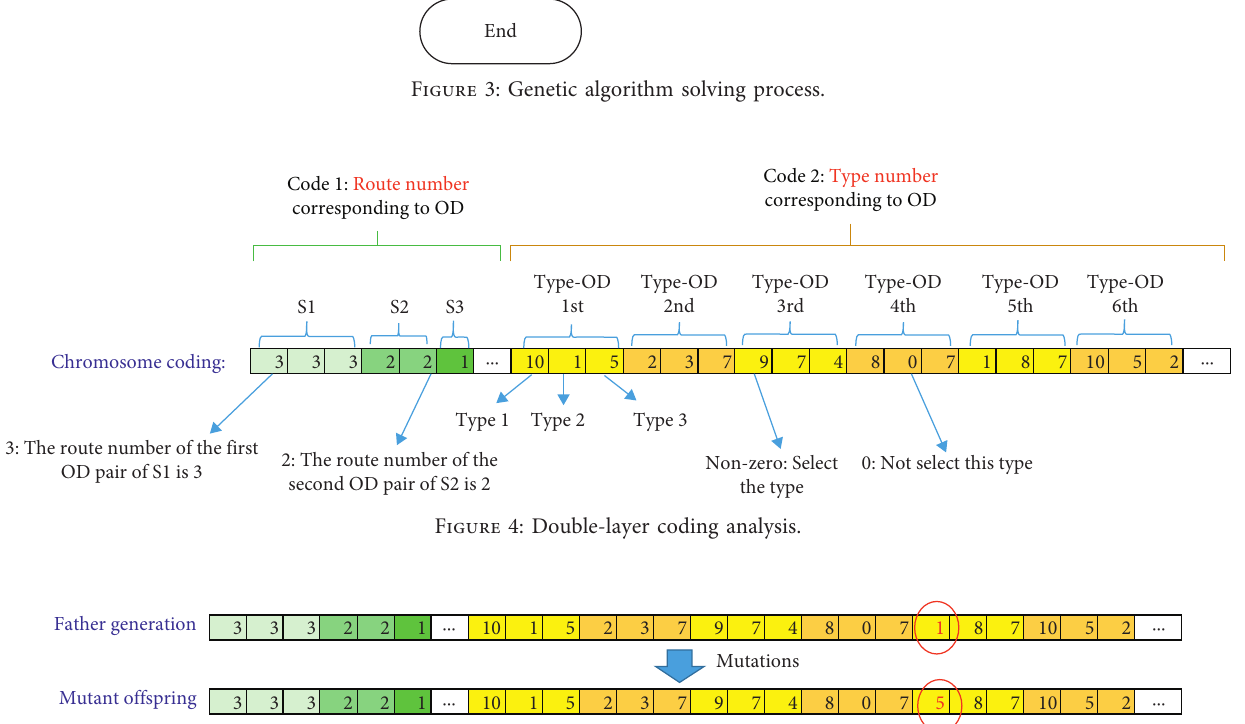
Figure 5: Variant